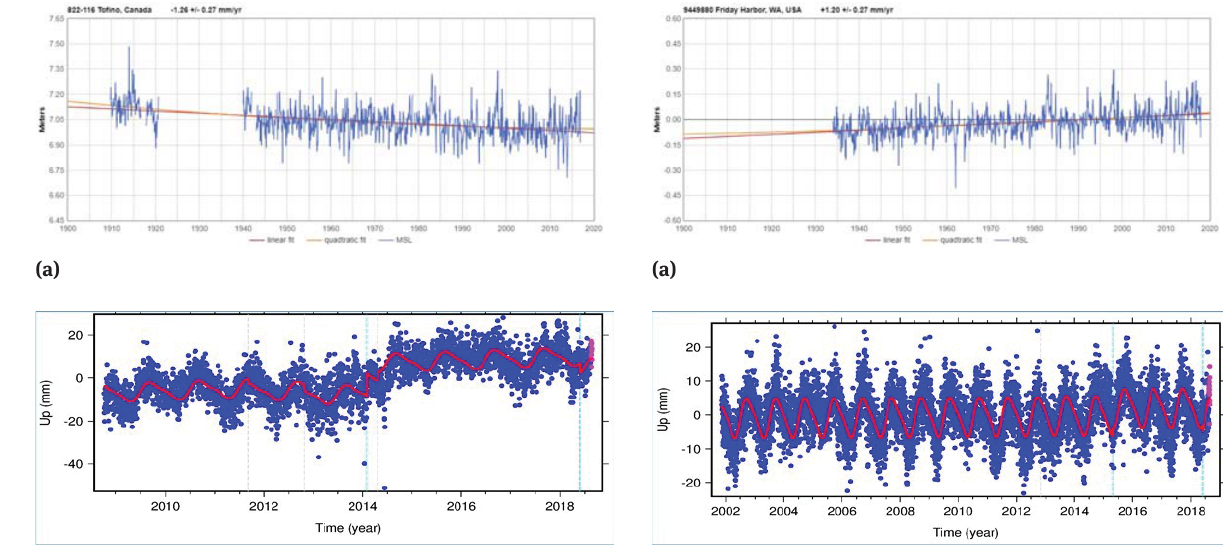
solute vertical velocity 0.23±0.24 mm/yr.